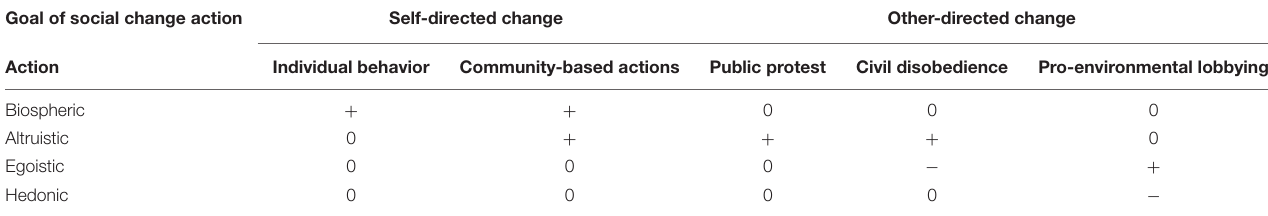
TABLE 4 | Summary of the relationships between values and social change